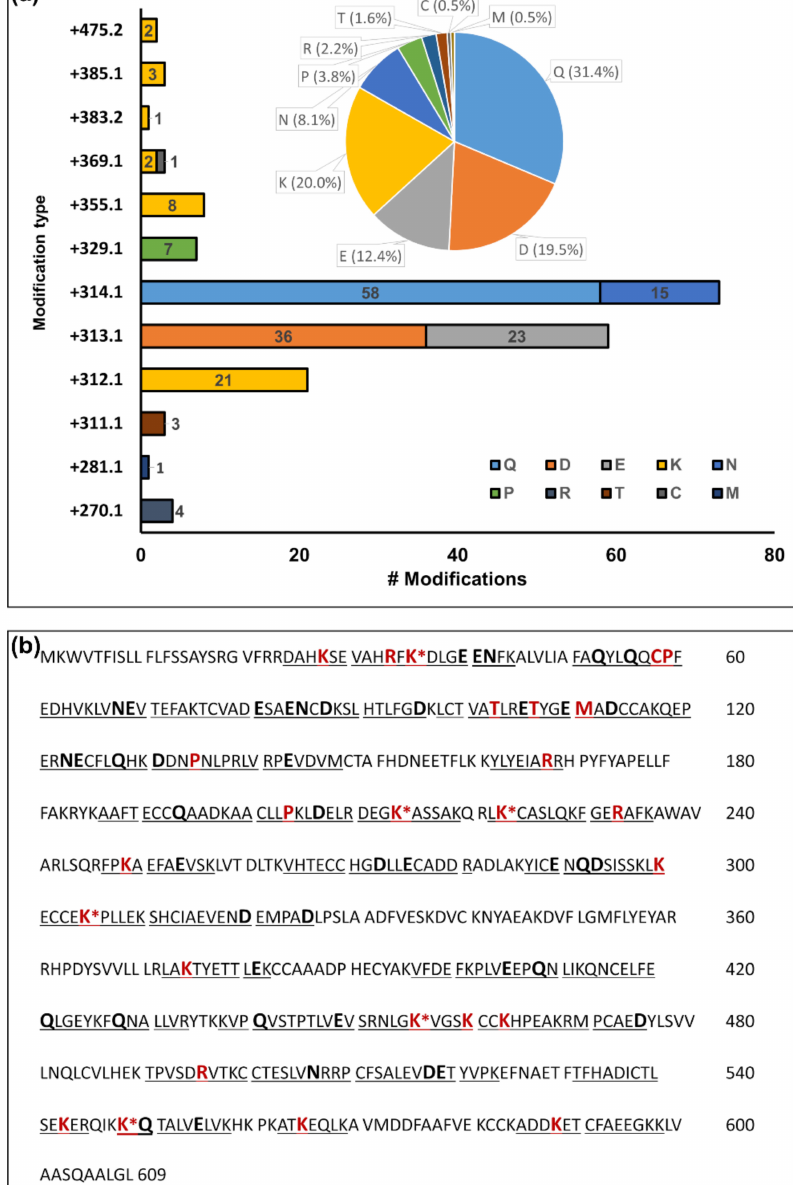
Figure 5. Frequency of modification types and modified amino acids ( a ) and respective modification sites ( b ) identified in HSA using plasma with a total protein content of 2 mg. The bar plot represents the total number of unique residues modified by each modification type and the pie diagram the proportion of each modified amino acid. The asterisk (*) indicates residues where more than one modification was confirmed. Bold capitals highlight modifications at Gln, Asn, Glu, and Asp. Bold red capitals highlight all other residues modified by reactive